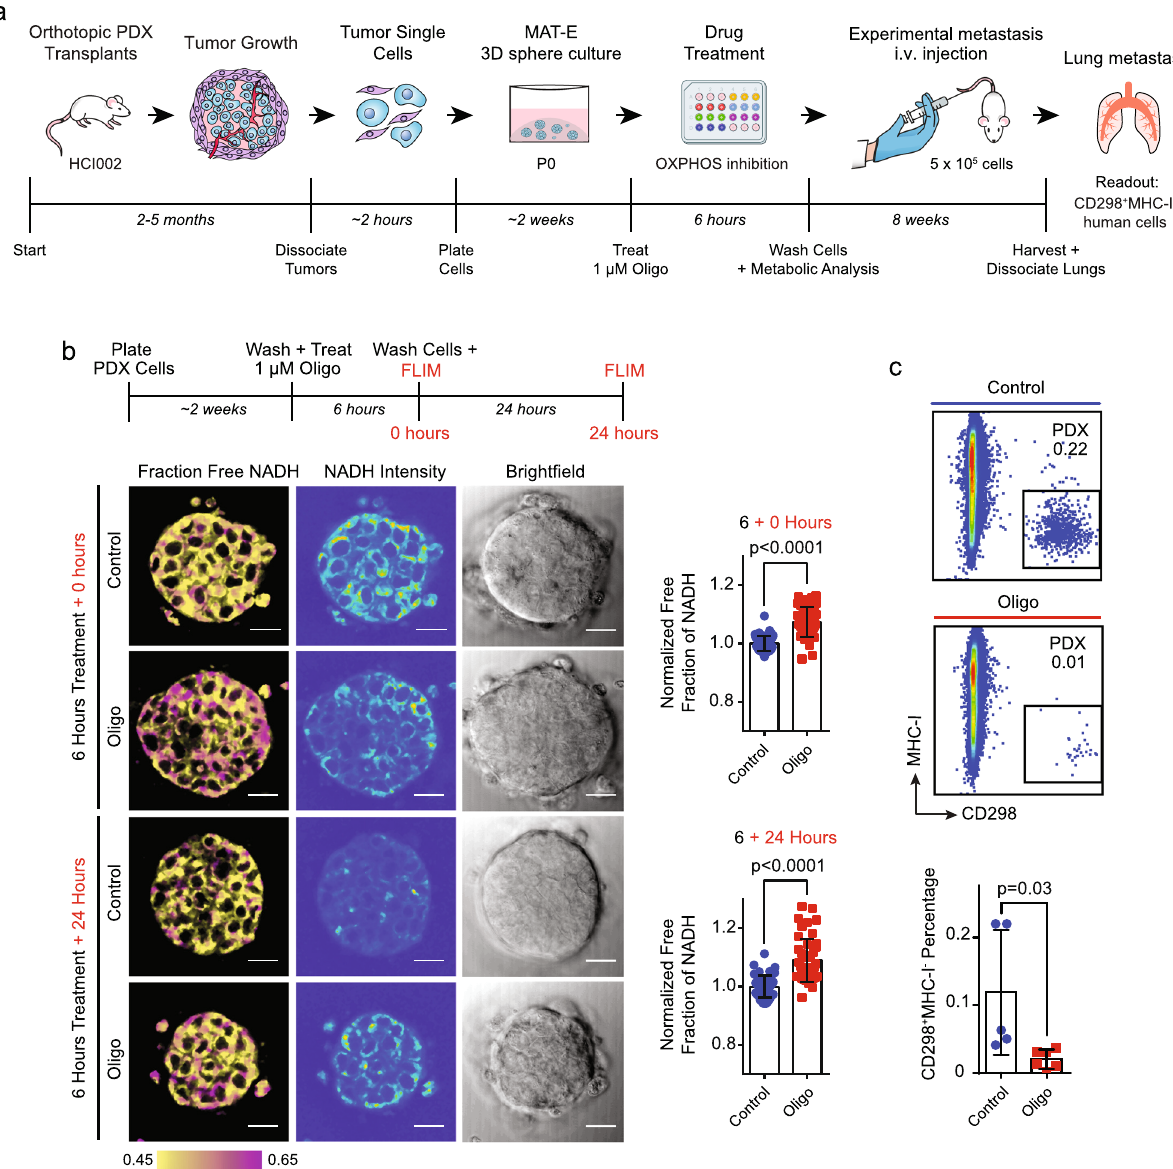
Fig. 6 Validation of PDX culture-transplant system for authentic investigation of metastasis in vivo. a Schematic shows experimental work fl ow to test the effects of OXPHOS inhibition on the metastatic capacity of cultured HCI002 PDX cells following i.v. injection in vivo. b Evaluation of the effects of oligo treatment on OXPHOS in PDX tumor spheres by FLIM imaging. Schematic shows experimental work fl ow (top panel). FLIM images show NADH fl uorescence signal in representative HCI002 spheres immediately after treatment with 1 µ M oligo or vehicle and replacement with drug-free medium (time = 0 hours) and 24 hours later ( + 24 hours) (bottom left panels). Scale bar = 20 µ m. Bar graphs show quanti fi cation of unbound free NADH fraction at 0 and 24 hours (right panels). Values are normalized to the free NADH fraction in control cells at each time point for each replicate, such that a value of 1 represents no change in free NADH compared with control. Values are presented as the mean ± s.d. P value determined by unpaired t test. Homoscedasticity was determined via F test. Control n = 47 spheres at time t = 0 and 24 hours; oligo n = 46 spheres at time t = 0 and 24 hours. c Comparison of metastatic burden in mice transplanted with oligo vs. vehicle-treated PDX cells. In all, 5 × 10 5 HCI002 PDX sphere cells were treated with 1 µ M oligo or vehicle for 6 hours, washed and transplanted i.v. as described in a . Flow cytometry plots show the percent of human CD29 + MHC-I − metastatic cells in the lungs of representative mice eight weeks later. The bar graph shows the quanti fi cation of the percent of metastatic cells in a cohort of control ( n = 5) and oligo ( n = 6) animals. Values are expressed as mean ± s.d. P value determined by unpaired t primary tumors and peripheral tissues including lungs, lymph nodes, bone mar- NSG mice using a 25µL Hamilton syringe. For experimental metastasis models, row, peripheral blood, and brains were harvested, dissociated to single cells and cells were suspended at a concentration of 5 ×10 6 cells/mL. In all, 5× 10 5 cells in stained with fl uorescently conjugated antibodies for CD298 (Biolegend, Cat. no. 100 µl of PBS were injected into the right ventricle of each NOD/SCID or NSG 341704) and MHC-I (eBioscience, Cat. no. 17-5957-82), and fl ow cytometry was mouse for i.c. injections or into the tail vein for i.v. injections. used to analyze and quantify disseminated CD298 + MHC-I − PDX cells using the BD FACSAria Fusion cell sorter (Becton, Dickinson and Company, Franklin Lakes, NJ, USA) as described previously 26 . Primary tumor volumes were calculated using Analysis of primary tumors and metastasis in distal tissues . Following caliper measurements with the equation: volume of an ellipsoid = 1/2(length × 8 – 14 weeks post orthotopic transplants, or ~8 weeks post i.c. or i.v. injections,